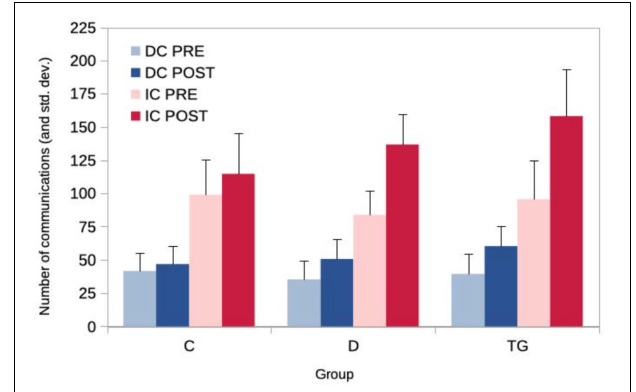
FIGURE 2 | Mean number of direct (DC) and indirect (IC) communications for the PRE and POST measures in the three groups.